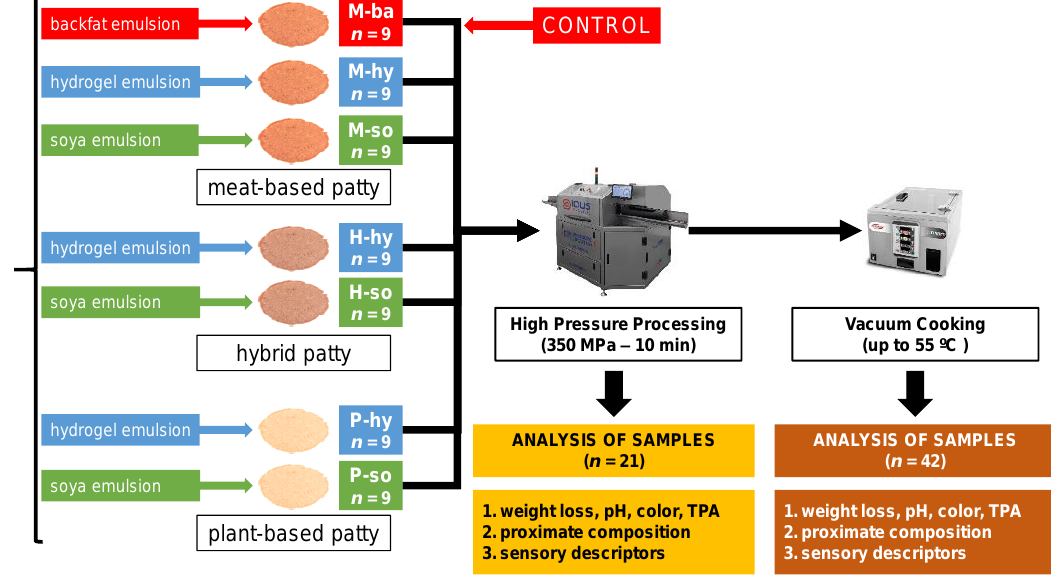
Figure 1. Experimental design for the sample elaboration and technological treatment according to the protein matrix (M; meat-based, H; hybrid and P: plant-based patties) and fat replacement ( ba : backfat, hy : hydrogel emulsion and so : soya emulsion).